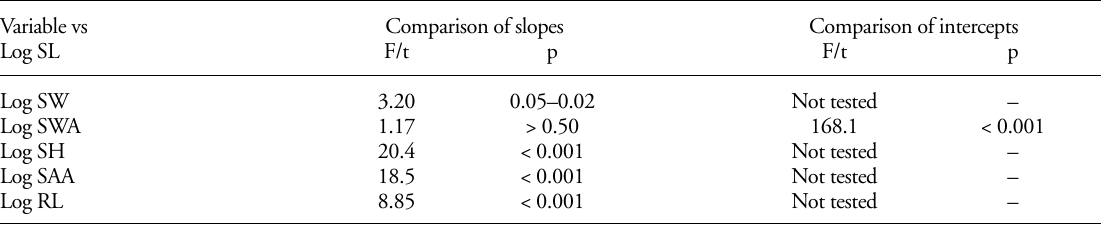
Table 5. Comparison of the regression lines for evaluating shape change during growth in the studied Patella species.